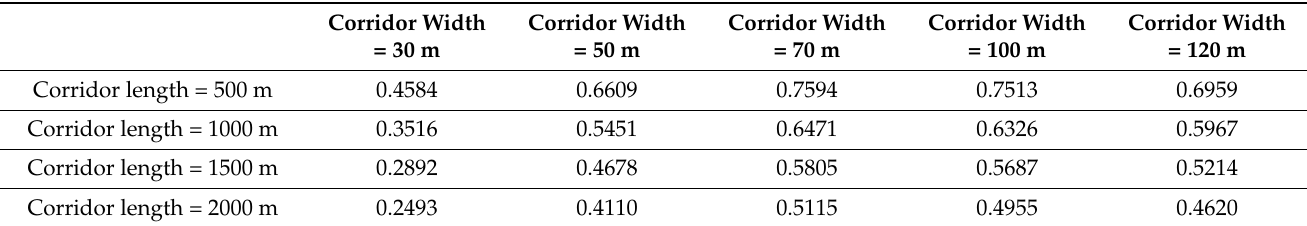
Figure 16. Ventilation conditions of corridors with different widths in the direction of − 90 degrees. Table 3. Ventilation degree of each corridor length and width when the wind direction was − 90 degrees.